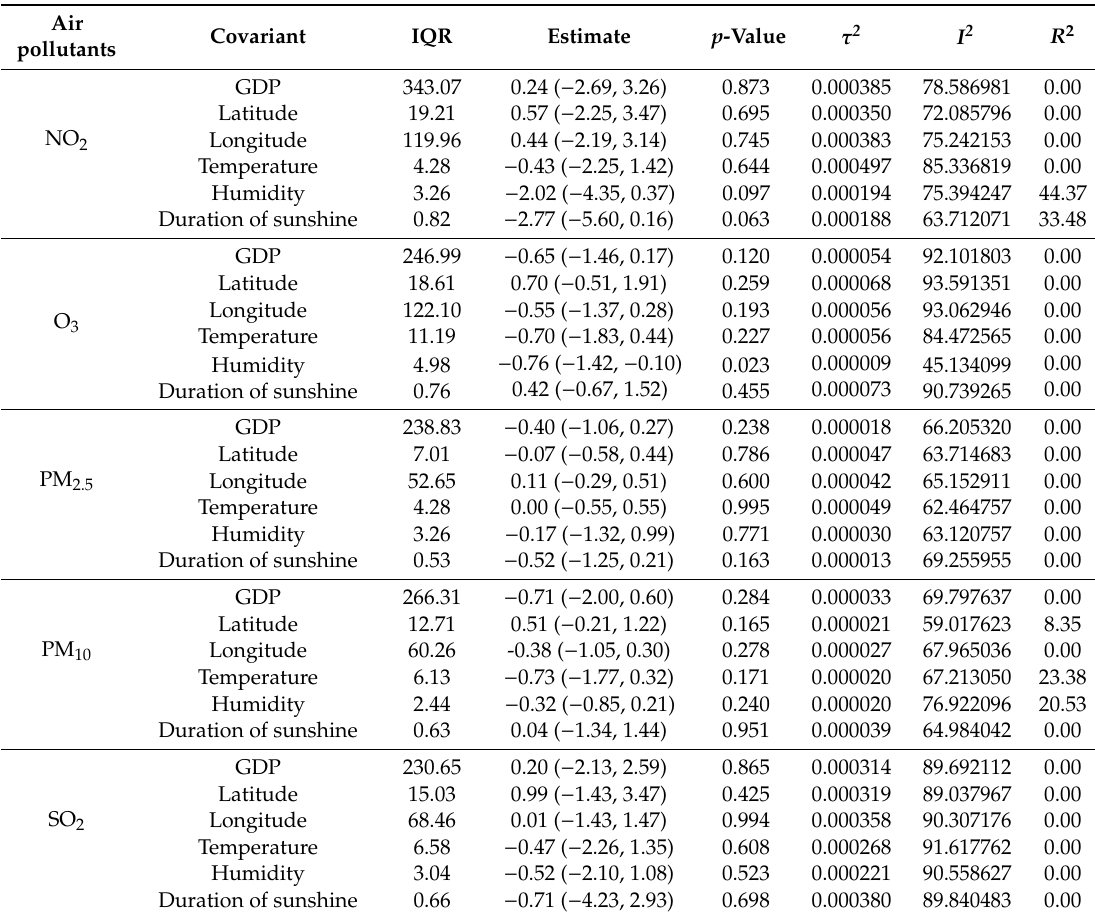
Table 3. Meta-regression analysis of study level predictors on the association between air pollution and risk of